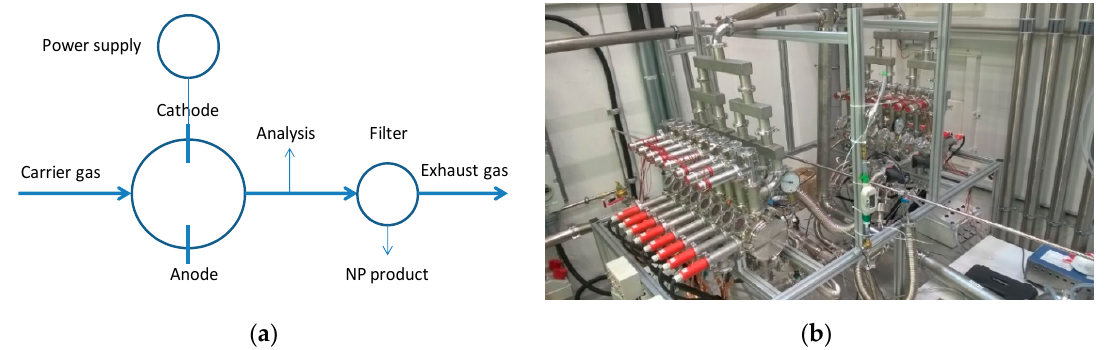
Figure 3. ( a ) Schematic overview of the BUONAPART-E concept for metallic nanoparticle production. ( b ) Multiple operating units (2 × 8) system at the University of Duisburg-Essen (UDE), Duisburg, Germany.